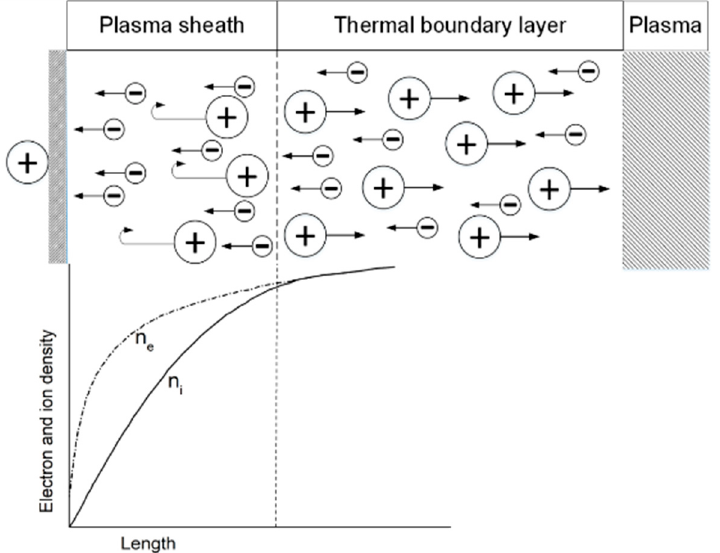
Figure 4. Motion of the activated particles near a positive reaction surface [23,38].